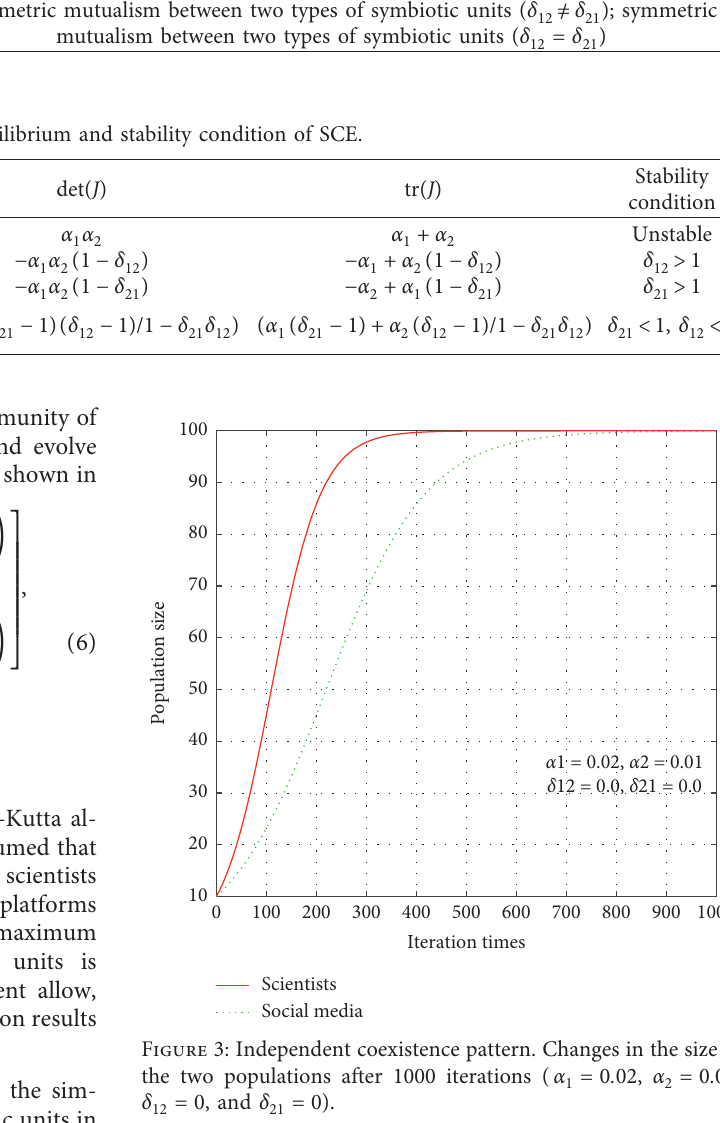
represents the influence coefficient of the 21